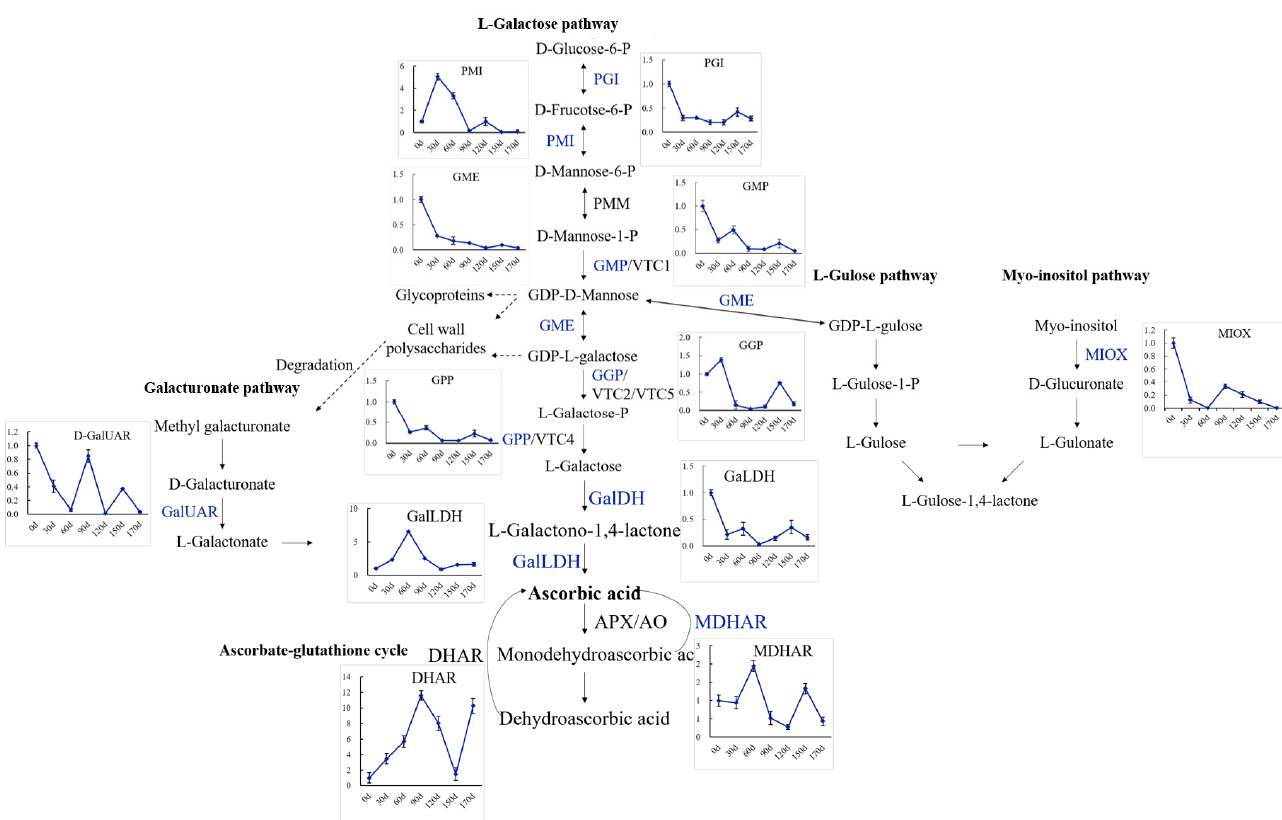
Figure 6. qRT-PCR validation of the expression profiles of candidate DEGs associated with AsA biosynthesis and metabolism in A. latifolia . Gene abbreviations are the same as those in Figure